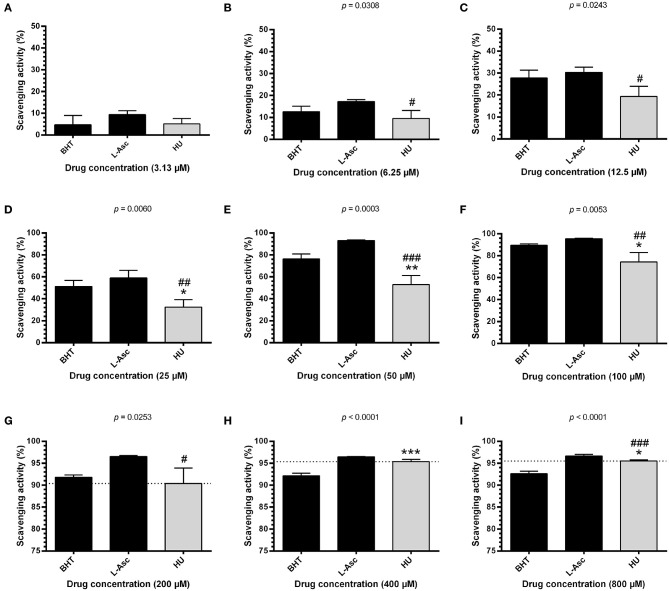
DPPH scavenging activity of different concentrations of hydroxyurea after 60 min of incubation. Antioxidant activity was measured by scavenging of the DPPH free radical using the HU concentrations 3.13 μM (A), 6.25 μM (B), 12.5 μM (C), 25 μM (D), 50 μM (E), 100 μM (F), 200 μM (G), 400 μM (H) and 800 μM (I). Results correspond to the mean ± standard deviation of four independent experiments. BHT and L-ascorbate were used as reference antioxidant compounds. HU, hydroxyurea; L-Asc, L-ascorbate; BHT, butylated hydroxytoluene. Statistical significance determined by one-way ANOVA, p < 0.0001, followed by Tukey's post-hoc test: HU vs. BHT: *p < 0.05, **p < 0.01, ***p < 0.001; HU vs. L-Asc, #p < 0.05, ##p < 0.01, ###p < 0.001.